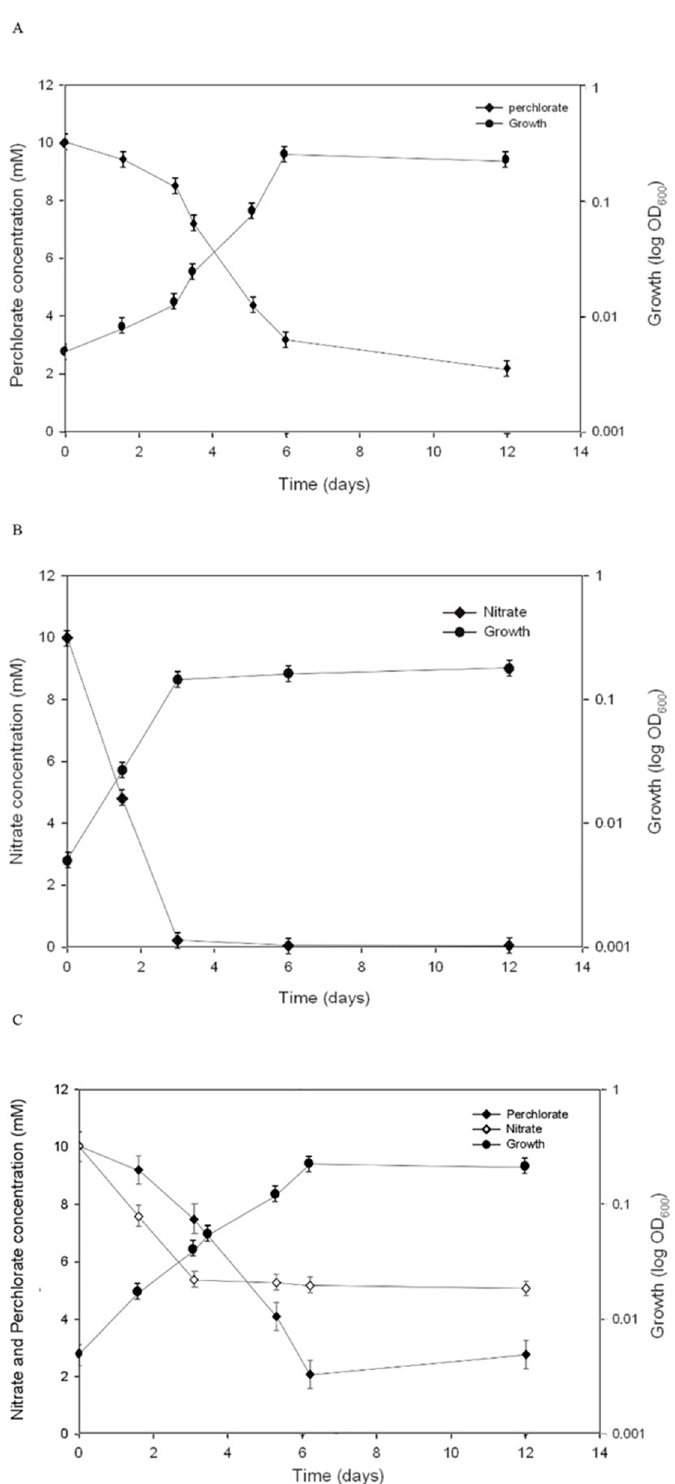
Figure 1. Growth, perchlorate and nitrate reduction. Aerobically grown strain at exponential phase was inoculated (0.005 OD600 mL − 1 ) under anaerobic conditions in fresh minimal medium and grown with perchlorate ( A ), nitrate ( B ) or both ions ( C ) as electron acceptors. Growth was monitored by OD600 measurement at indicated time. Each value represents the average of three experiments.